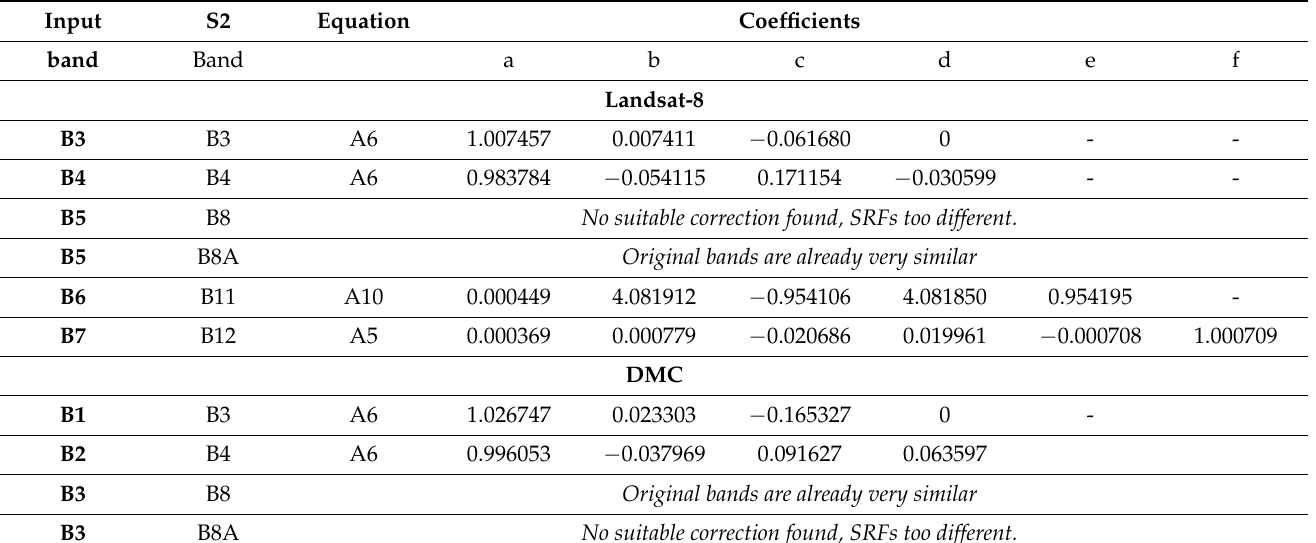
Table 6. Selected SRF correction functions.